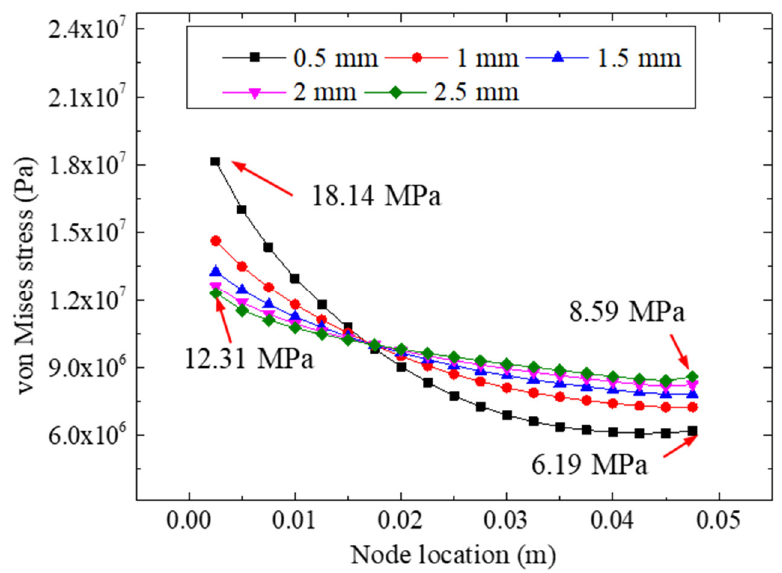
Figure 16. The von Mises stresses for different bonding thicknesses.